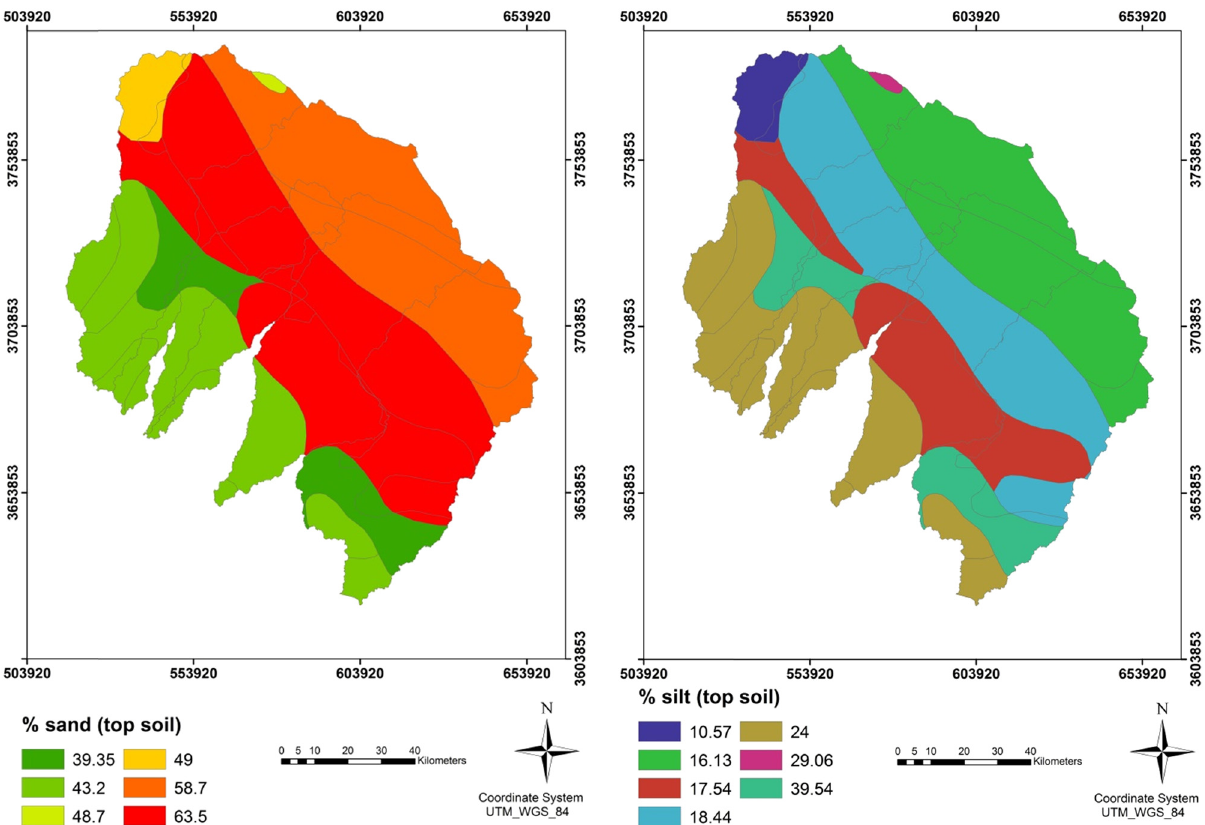
Figure 7: Sand percentage distribution of study area topsoil. Figure 8: Silt percentage distribution of study area